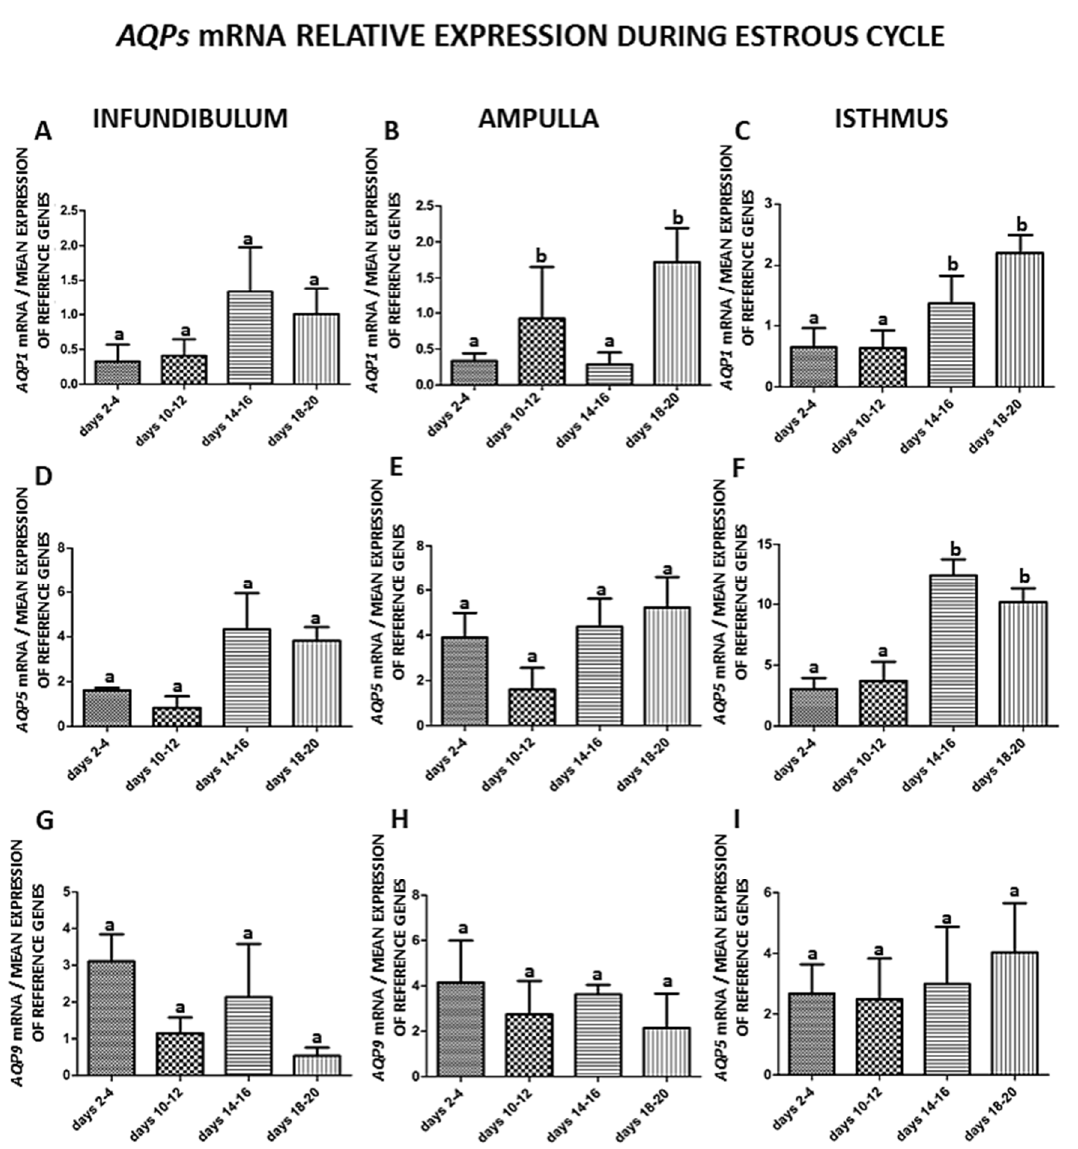
Figure 1. The expression patterns of Aquaporin 1 ( A , B , C ) , Aquaporin 5 ( D , E , F ) and Aquaporin 9 ( G , H , I ) genes in porcine oviduct separated into infundibulum, ampulla and isthmus from the estrus cycle (days 2–4, 10–12, 14–16, 18–20). The samples were subjected to quantitative polymerase chain reaction (qPCR) analysis and normalized to the geometric mean of 18S RNA and Cyclophilin A ( PPIA ) expression. Each of the graphs marked with a capital letter indicates a specific part of the oviduct. Values are expressed as means ± S.E.M from five individuals, each performed in triplicate ( p < 0.05) ( n = 5). Statistically significant differences between the part of the oviduct to day of the estrous cycle are indicated by different letters (a, b).